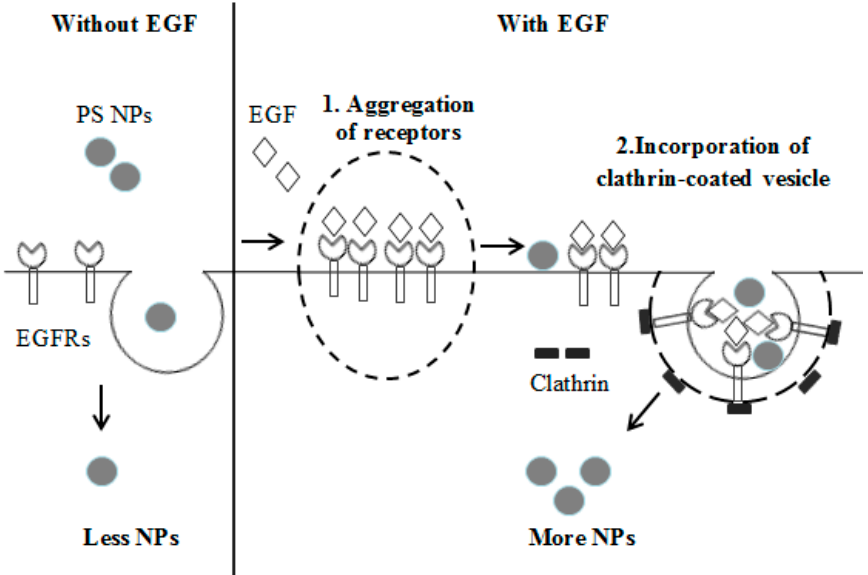
Figure 5. Hypothesis explaining the molecular mechanism for cellular uptake of PS NPs. When culture medium lacks EGF, most PS NPs pass through the cell membrane via the endocytosis pathway. In the presence of added EGF, the aggregation of EGFRs provides more space on the cell membrane, allowing NPs to enter the cells easier, and also NPs could combine with the EGF-EGFR complex, allowing their uptake into the cells through clathrin-mediated endocytosis.